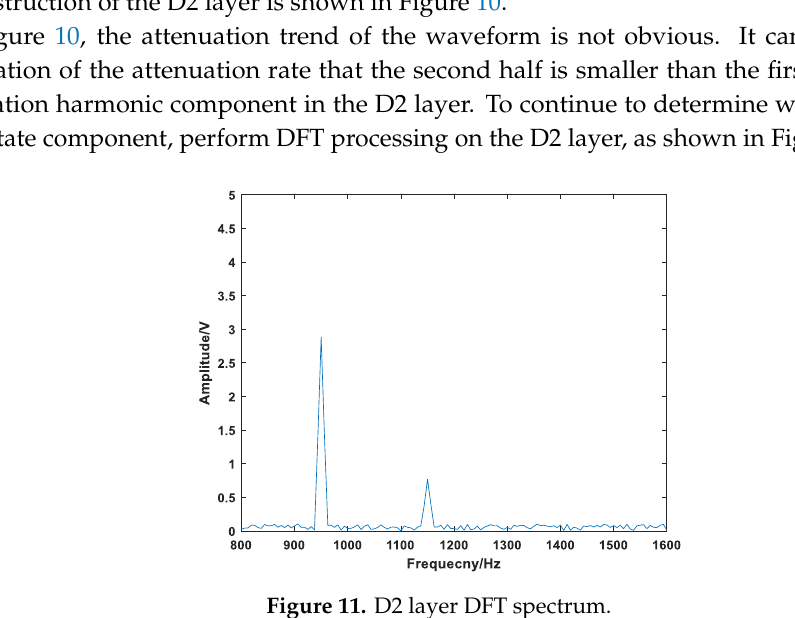
Figure-10. D2 layer reconstruction waveform.